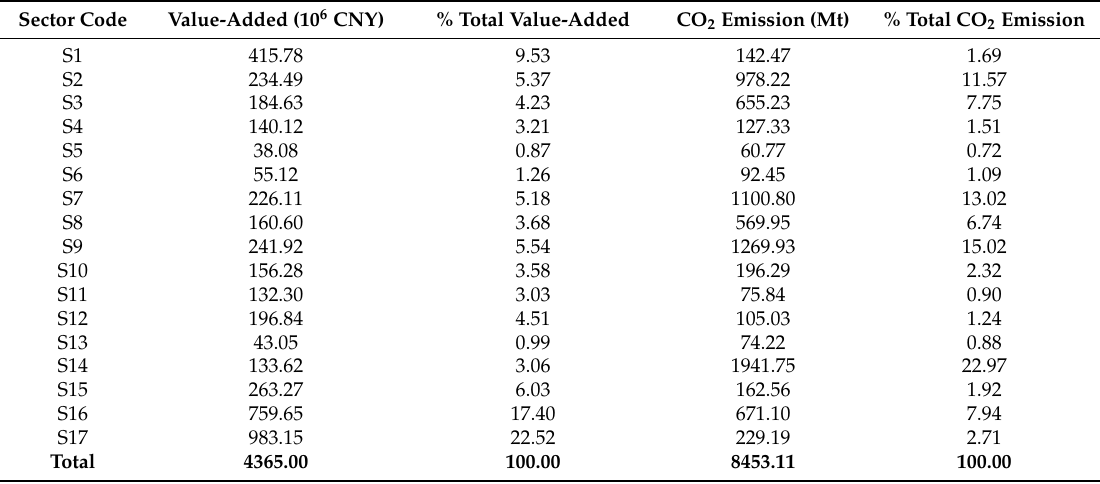
Table 3. The value-added and CO 2 emission of China’s 17 sectors in 2010.